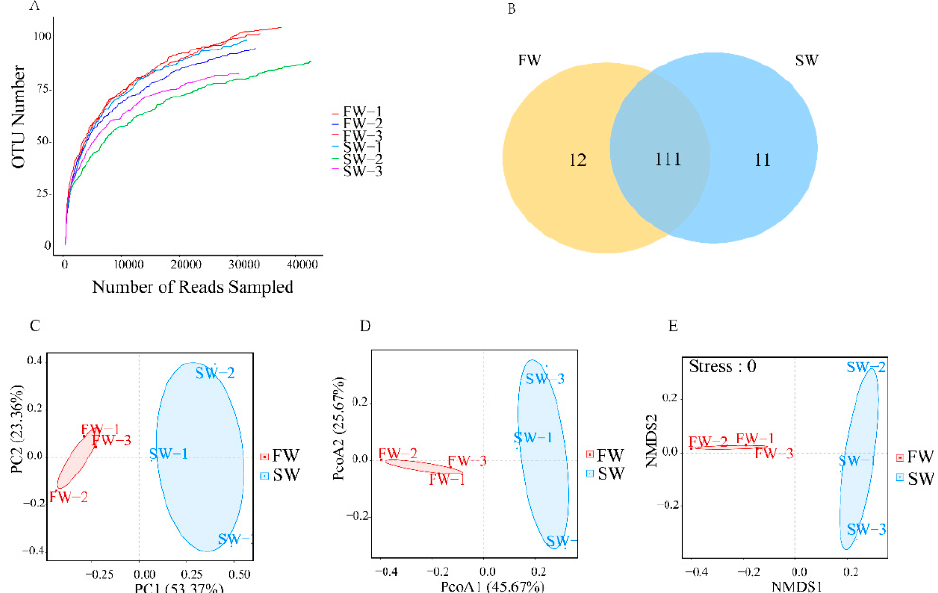
Figure 1. Compositional variation in microbial communities between FW leeches and SW leeches. ( A ) Alpha-diversity rarefaction plot of fecal microbiotas between FW leeches and SW leeches. The X- and Y-axes represent sample size and number of observed OTUs, respectively. ( B ) Venn diagram of OTU in FW leeches and SW leeches. Venn diagram summarizing the overlap of OTUs of leech fecal microbiota in FW leeches and SW leeches. ( C ) Principal Component Analysis (PCA) of bacterial diversity of FW leeches and SW leeches. ( D ) Principal co-ordinates analysis (PCoA) of bacterial diversity based on the Bray–Curtis distance of OTUs of FW leeches and SW leeches. ( E ) Non-metric Multidimensional Scaling (NMDS) ordination between microbial communities of FW leeches and SW leeches. Each point represents an individual leech sample. Table 1. Phylogenetic diversity indices of FW and SW. Sequence coverage bacterial diversity indices: Chao1, Ace, and Shannon index in leeches.